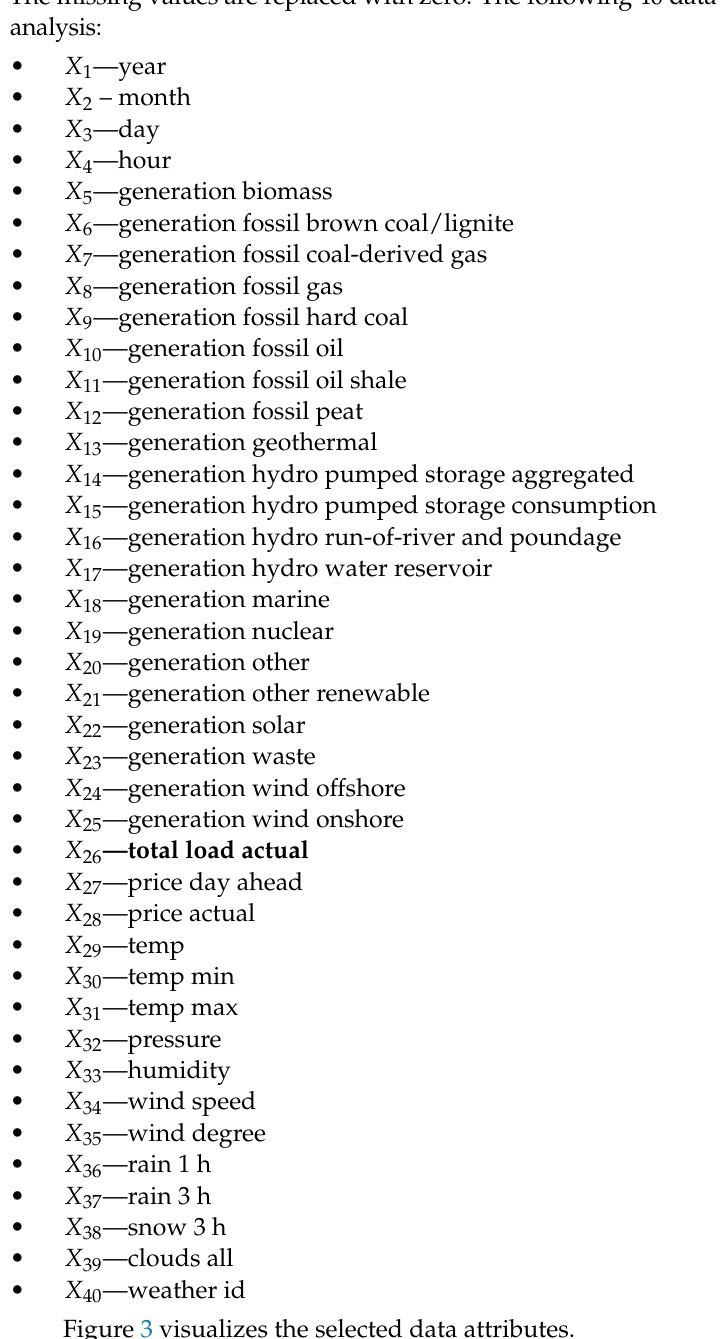
Figure 3 visualizes the selected data